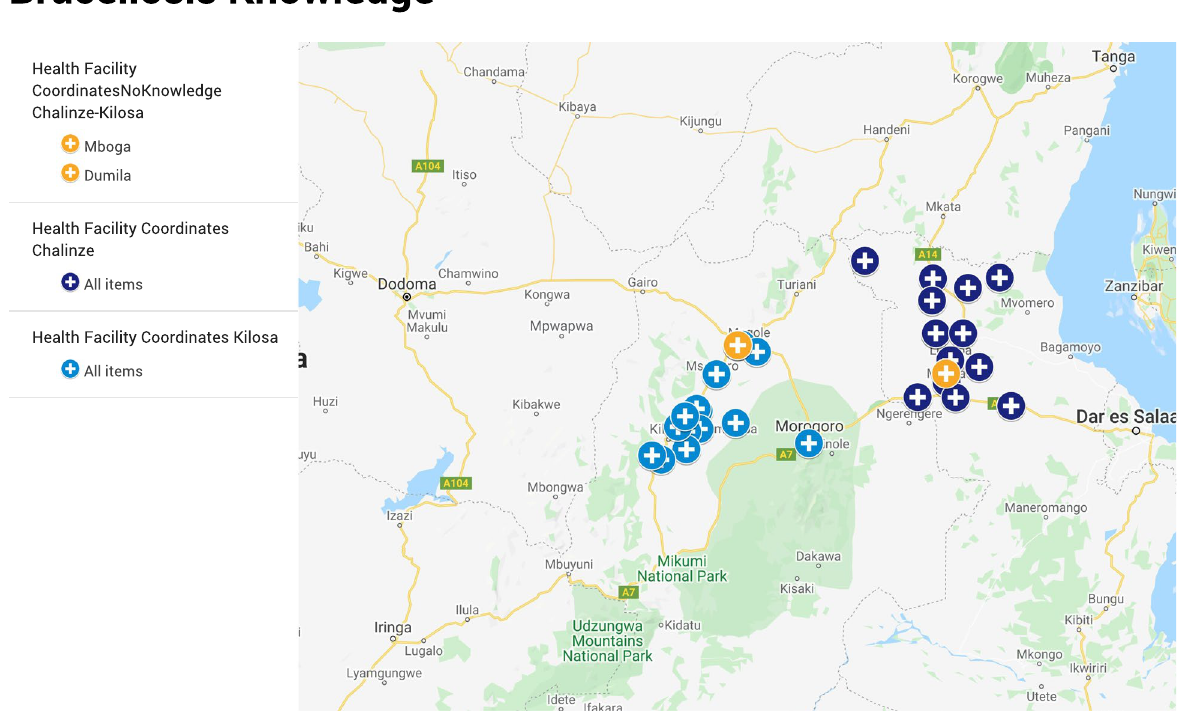
Fig. 1 The map showing selected ward health facilities in Kilosa and Chalinze districts in Tanzania. Map created by ArcView GIS software version 3.2. Shapefiles for administrative boundaries from the 2012 census were sourced from the Tanzania National Bureau of